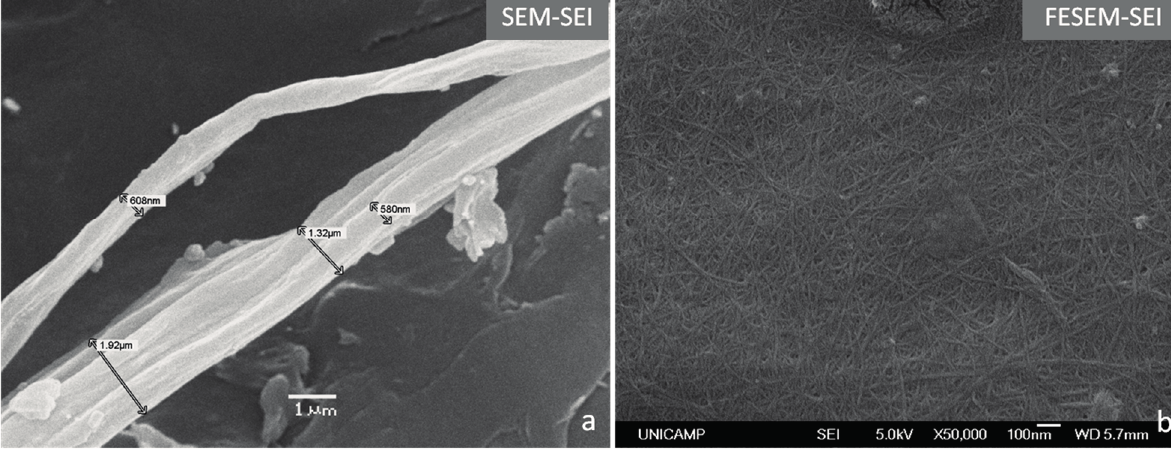
Figure 2. Scanning electron micrographs showing the hydrolytic effects of Xanthomonas axonopodis pv. citri enzymes on CB: ( a ) fibers and bundle of fibers; ( b ) nanocellulose fibers in